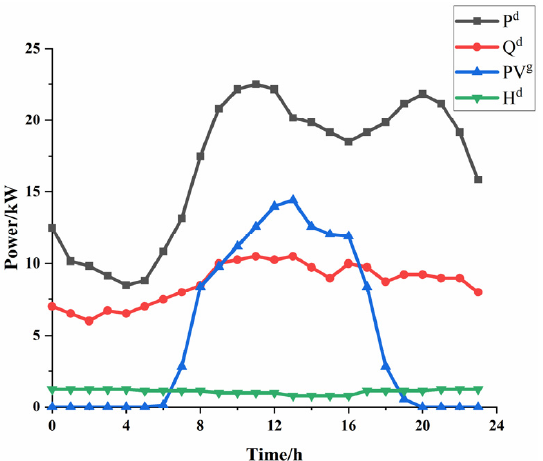
Figure 4. Power and heat demand, as well as available solar power.